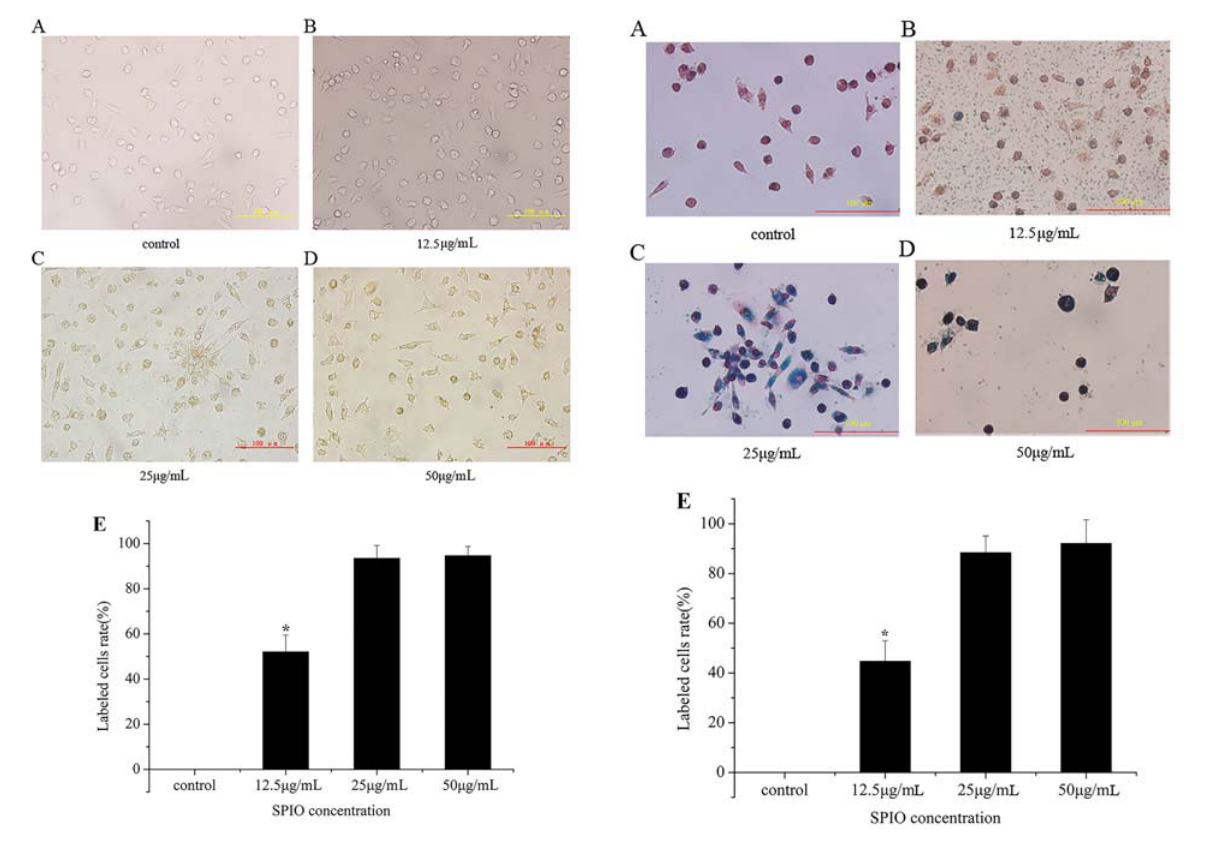
Figure 4. Iron levels in cells shown by staining with Prussian blue after superparamagnetic iron oxide (SPIO) transfection into endothelial progenitor cells. A , Control group; SPIO concentra- tions: B , 12.5 m g/mL; C , 25 m g/mL; and D , 50 m g/mL (scale bar 100 m m). E , Bar graph of panels A, B, C, and D. Data are reported as means ± SD. *P o 0.05 compared to control group (ANOVA). iron granules with different degrees of aggregation were noted in the cell plasma. Therefore, SPIO at concentrations of 12.5, 25, and 50 m g/mL were successfully transfected